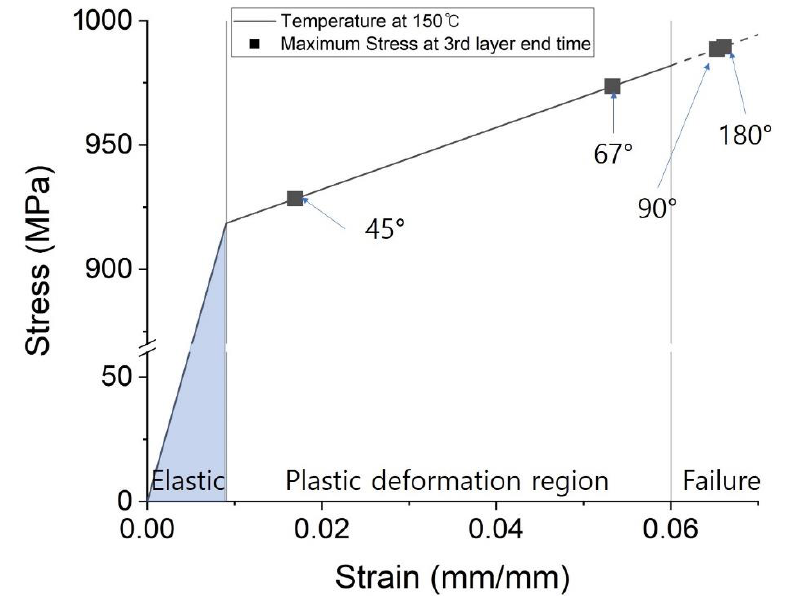
Figure 12. Maximum residual stress results of simulations.